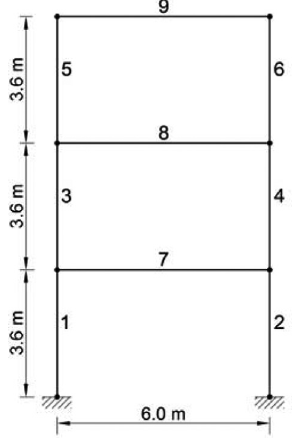
Fig. 5. Three-story plane steel frame with fi nite-element model.